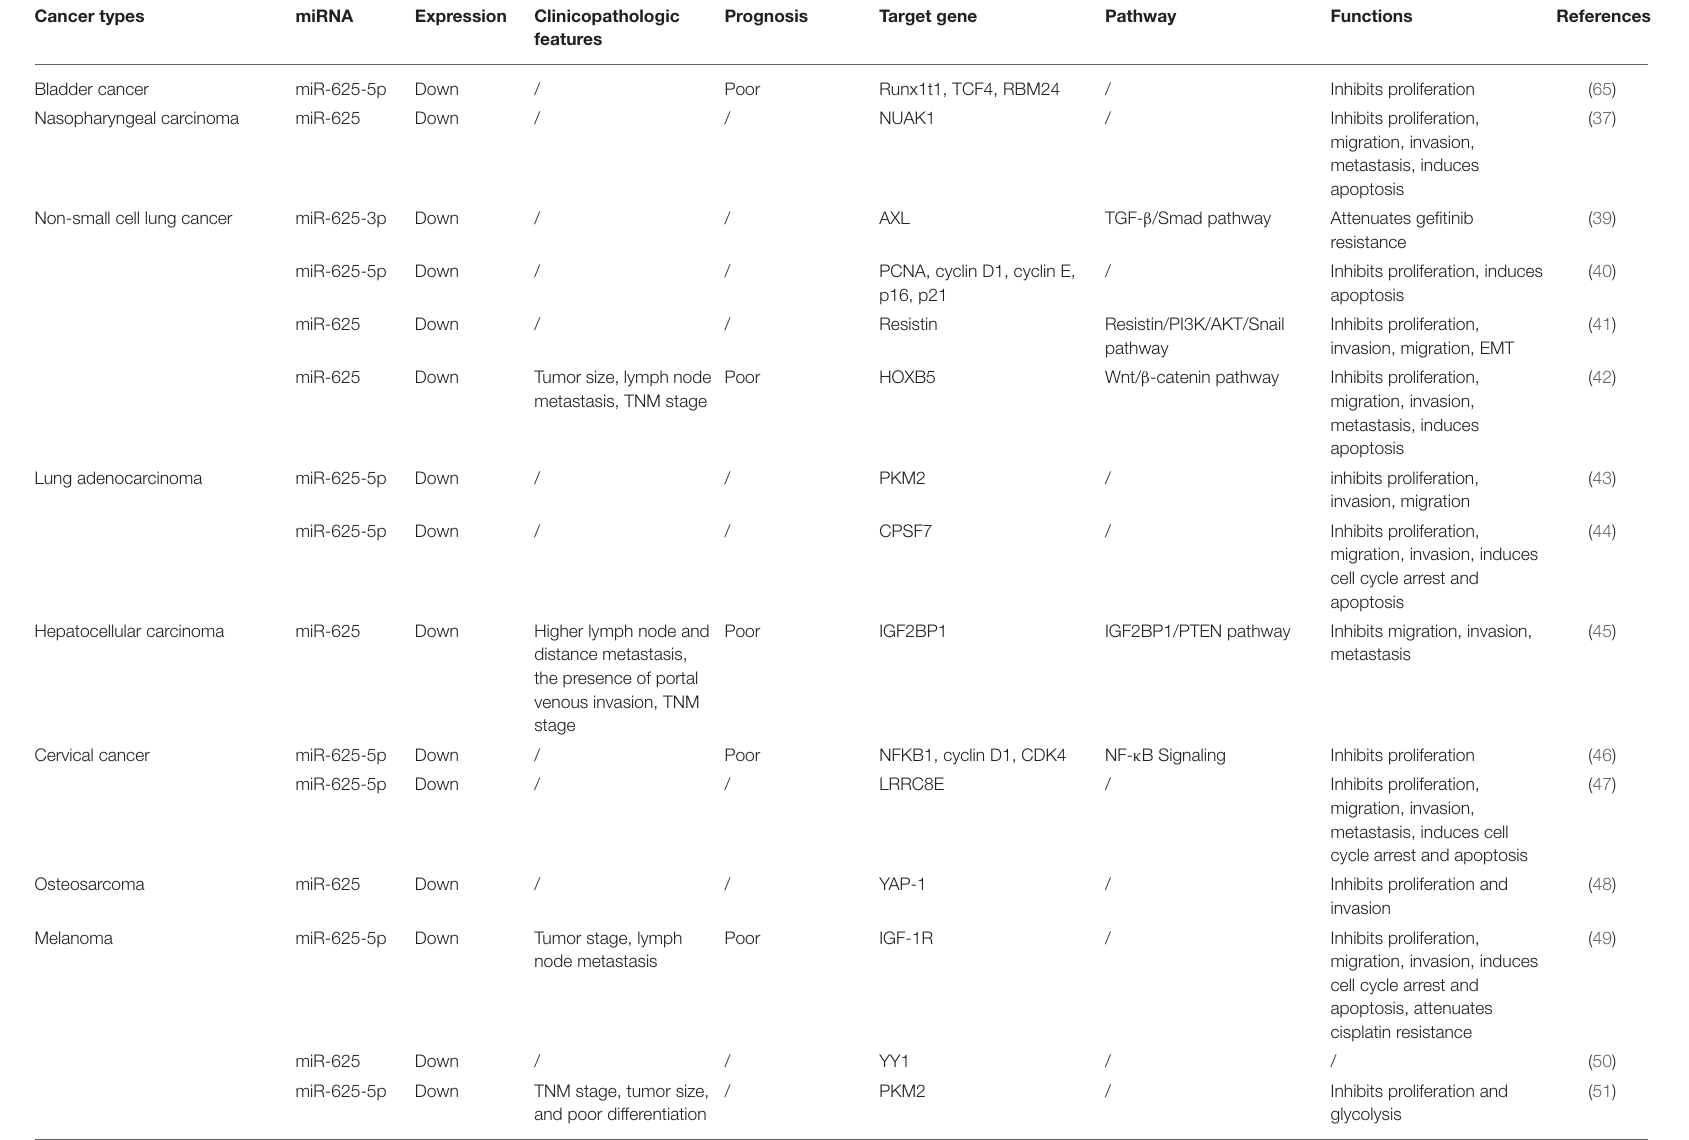
TABLE 1 | The expression, clinical significance, function, and mechanism of miR-625 in different